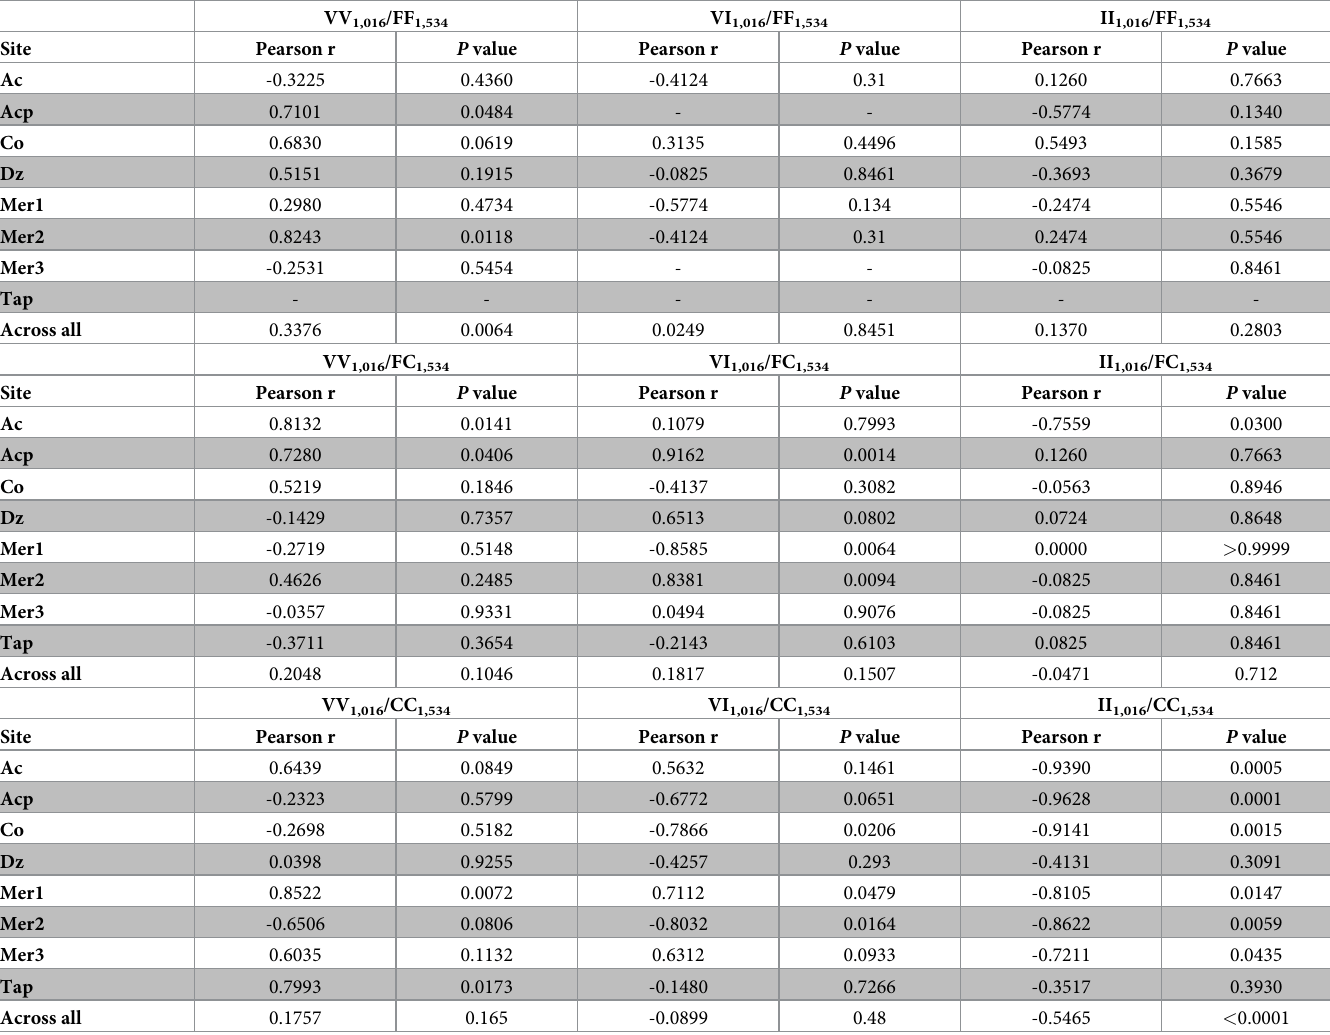
Table 6. Pearson’s correlation coefficient and p value for nine dilocus genotypes at loci V1,016I and